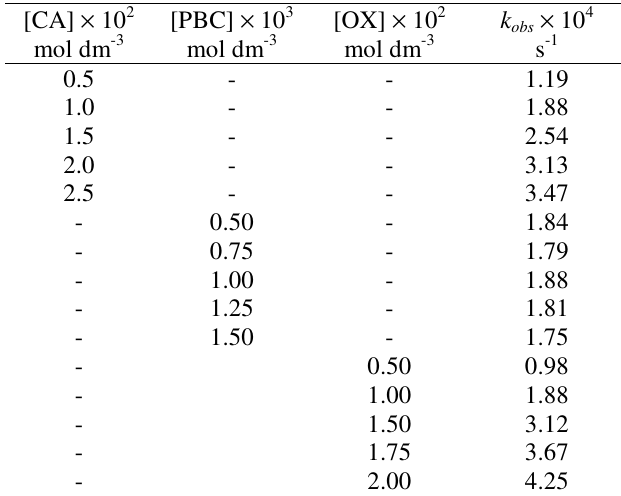
Table 1 . Effect of [CA], [PBC] and [OX].